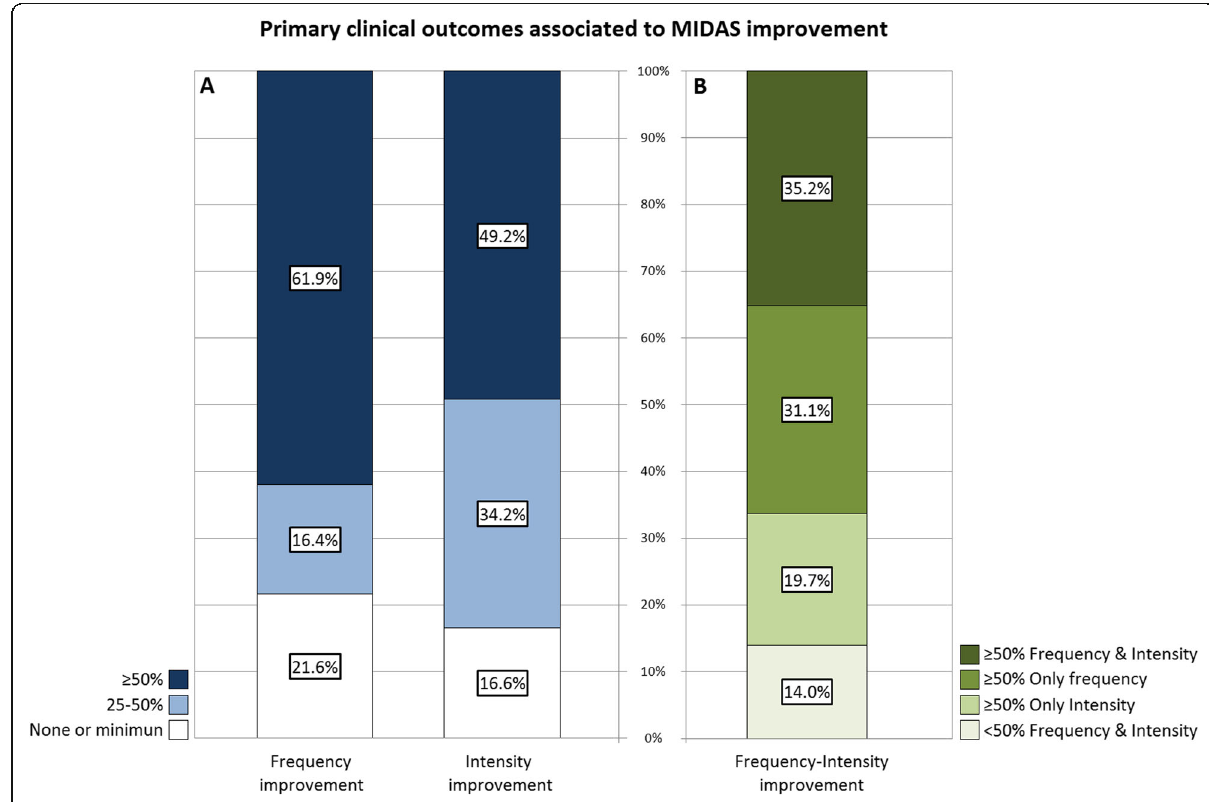
Fig. 1 Clinical outcomes that showed significant association with ≥ 50% MIDAS score reduction after 6 months of preventive treatment with OnabotulinumtoxinA. a shows response rate in frequency, intensity, and ( b ) co-variable frequency-intensity according to treatment